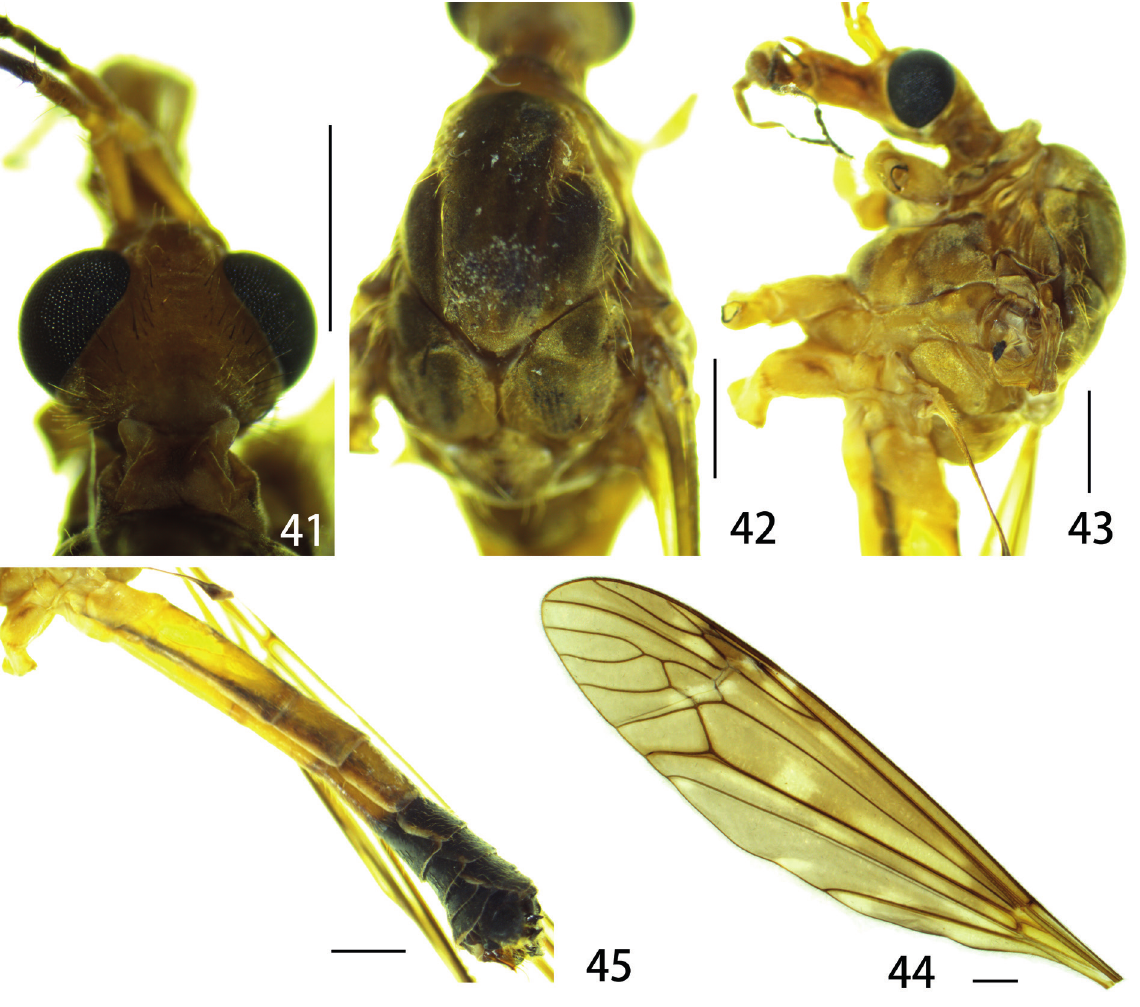
Figs 41–45. Tipula ( Vestiplex ) singularis sp. nov., ♂ , holotype (coll. Inse-YN0502). 41 . Head, dorsal view. 42 . Thorax, dorsal view. 43 . Thorax, lateral view. 44 . Wing. 45 . Abdomen, lateral view. Scale bars = 1.0